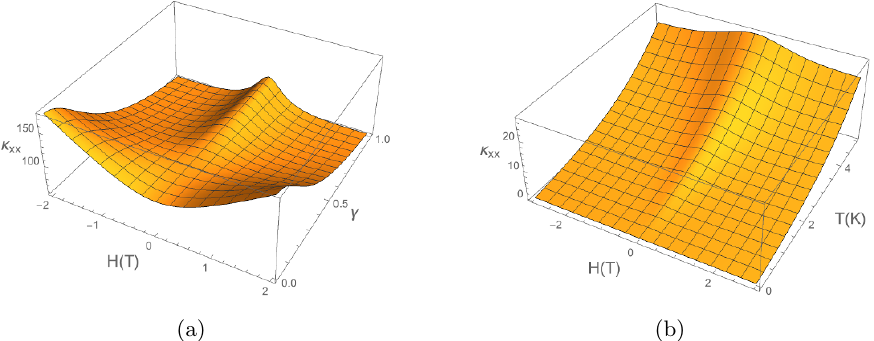
Figure 7 . Longitudinal thermal conductivity (cid:20) xx (a) as a function of Magnetic doping and magnetic (cid:12)eld at T = 2 K , (b) as a function of Temperature and magnetic (cid:12)eld at q (cid:31) (cid:13) = 0 :